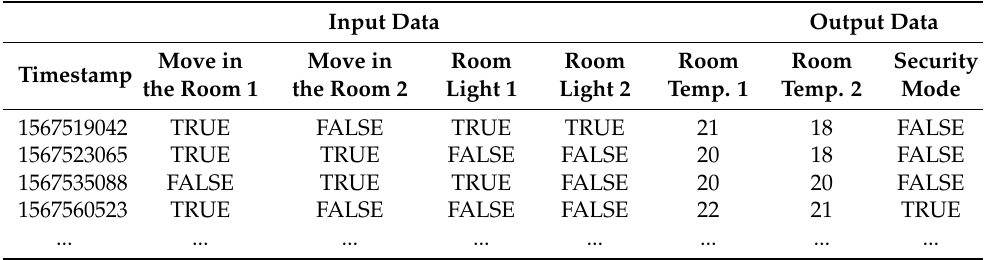
Table 4. A fragment of the data from the training sample to ensure an optimal configuration of the home security system.